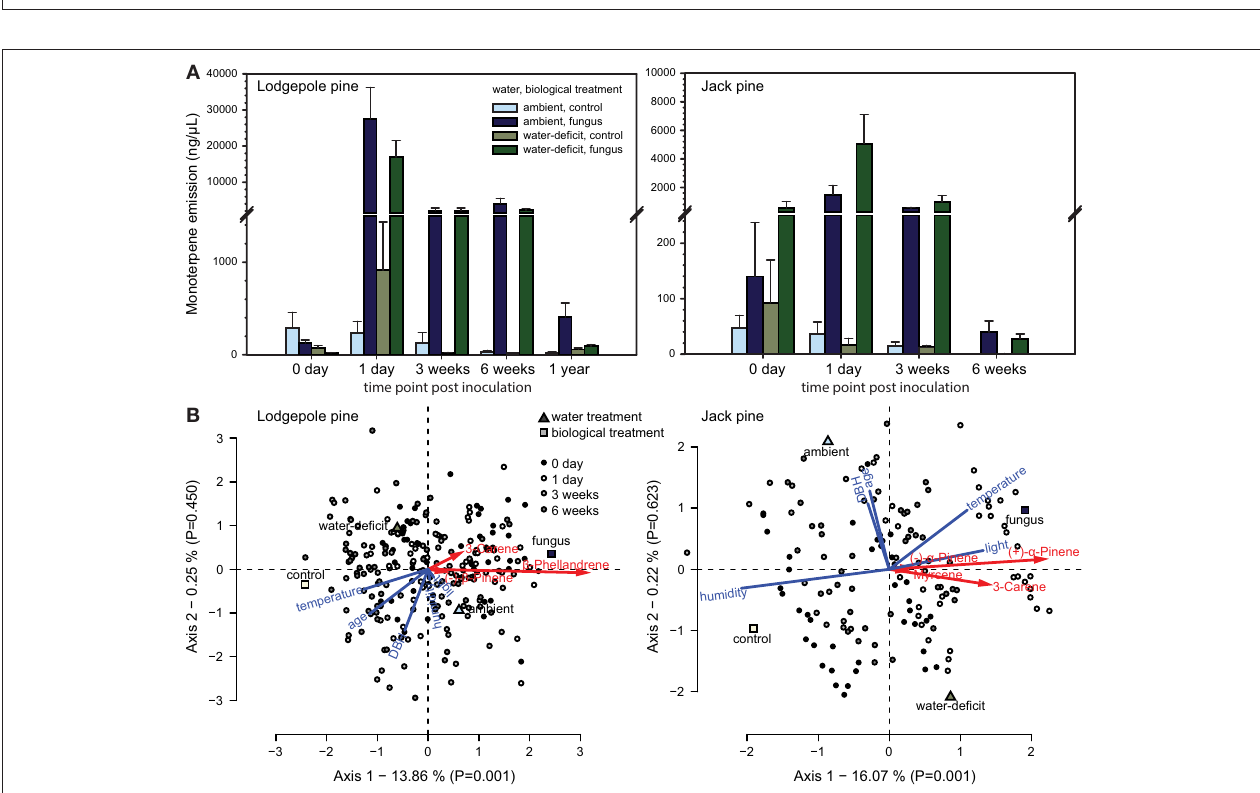
FIGURE 3 | (A) Total monoterpene emission (mean + S.E.) of ambient and water-deficit lodgepole ( P. contorta ) and jack ( P. banksiana ) pines before (0 days) and after biological treatment (1 day, 3 and 6 weeks; and 1 year in lodgepole pine) application. Water treatment had no effect, but fungal inoculation increased volatile emission in both pine species (repeated measures ANOVA, lodgepole pine: P < 0.001 ; jack pine: P < 0.001 ; (B) Canonical redundancy analysis (RDA) triplots (scaling 2) illustrating the influence of water and biological treatments as well as tree characteristics [age, and diameter at breast height (DBH)] and environmental variables [temperature, humidity, and light intensity (light)] on volatile emission of individual monoterpenes in lodgepole pine ( P. contorta ) and jack pine ( P. banksiana ).